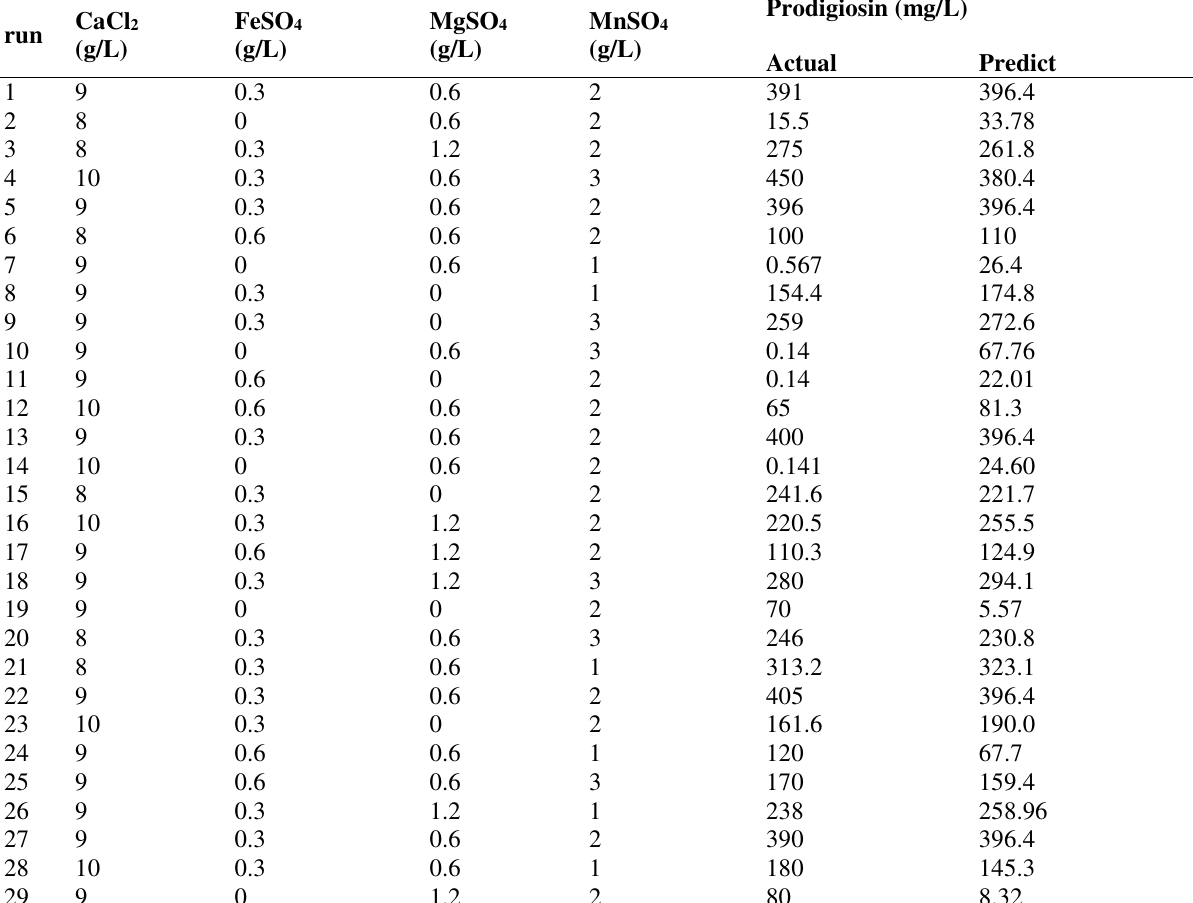
Fig 5. The effect inoculum size on prodigiosin production by S. marcescens in chemically defined liquid medium. Coded experimental design and results for the response surface of prodigiosin production from S. marcescens as a function of trace element